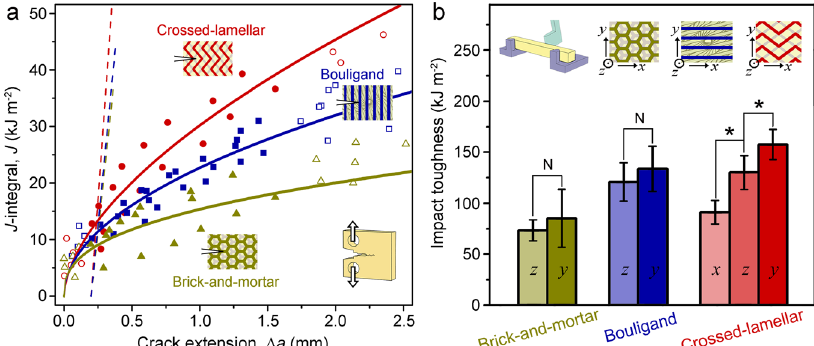
Fig. 5 Fracture and impact toughnesses of the bioinspired Mg-Ti composites with different architectures. a Variations in J -integral as a function of the crack extension Δ a along with the fi tted R-curves for the composites. The loading con fi gurations and cracking directions with respect to the architectures are illustrated in the insets. The dash lines for determining the fracture toughnesses have a slope of ð σ b Impact toughnesses of the bioinspired composites when loaded along different directions as illustrated in the insets. The speci fi c loading directions, which are clearly illustrated in Supplementary Fig. 2, are marked in the columns. Error bars represent standard deviation. The symbols “ ★ ” and “ N ” indicate that the differences are statistically signi fi cant and insigni fi cant, respectively, with a signi fi cance level of P value < 0.05 tested using two-tailed Student ’ s t